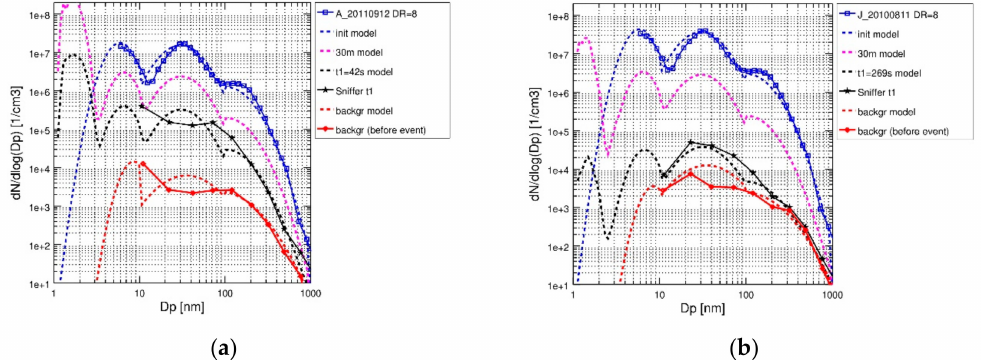
Figure 4. Comparison of the modeled particle size distributions at peak time t 1 with the particle size distributions recorded at Sni ff er; ( a ) Helsinki ship event A_20110912; ( b ) Turku ship event J_20100811. The solid and dashed blue and black lines show the particle size distributions after the initial dilution and at the time t1, respectively. Both events are from the summertime field campaigns. The individual measurements recorded at Sni ff er are shown as black stars. Modeled size distribution after a distance of 30 m downwind is indicated as a dashed magenta line. The urban background concentrations are shown as solid and dashed red